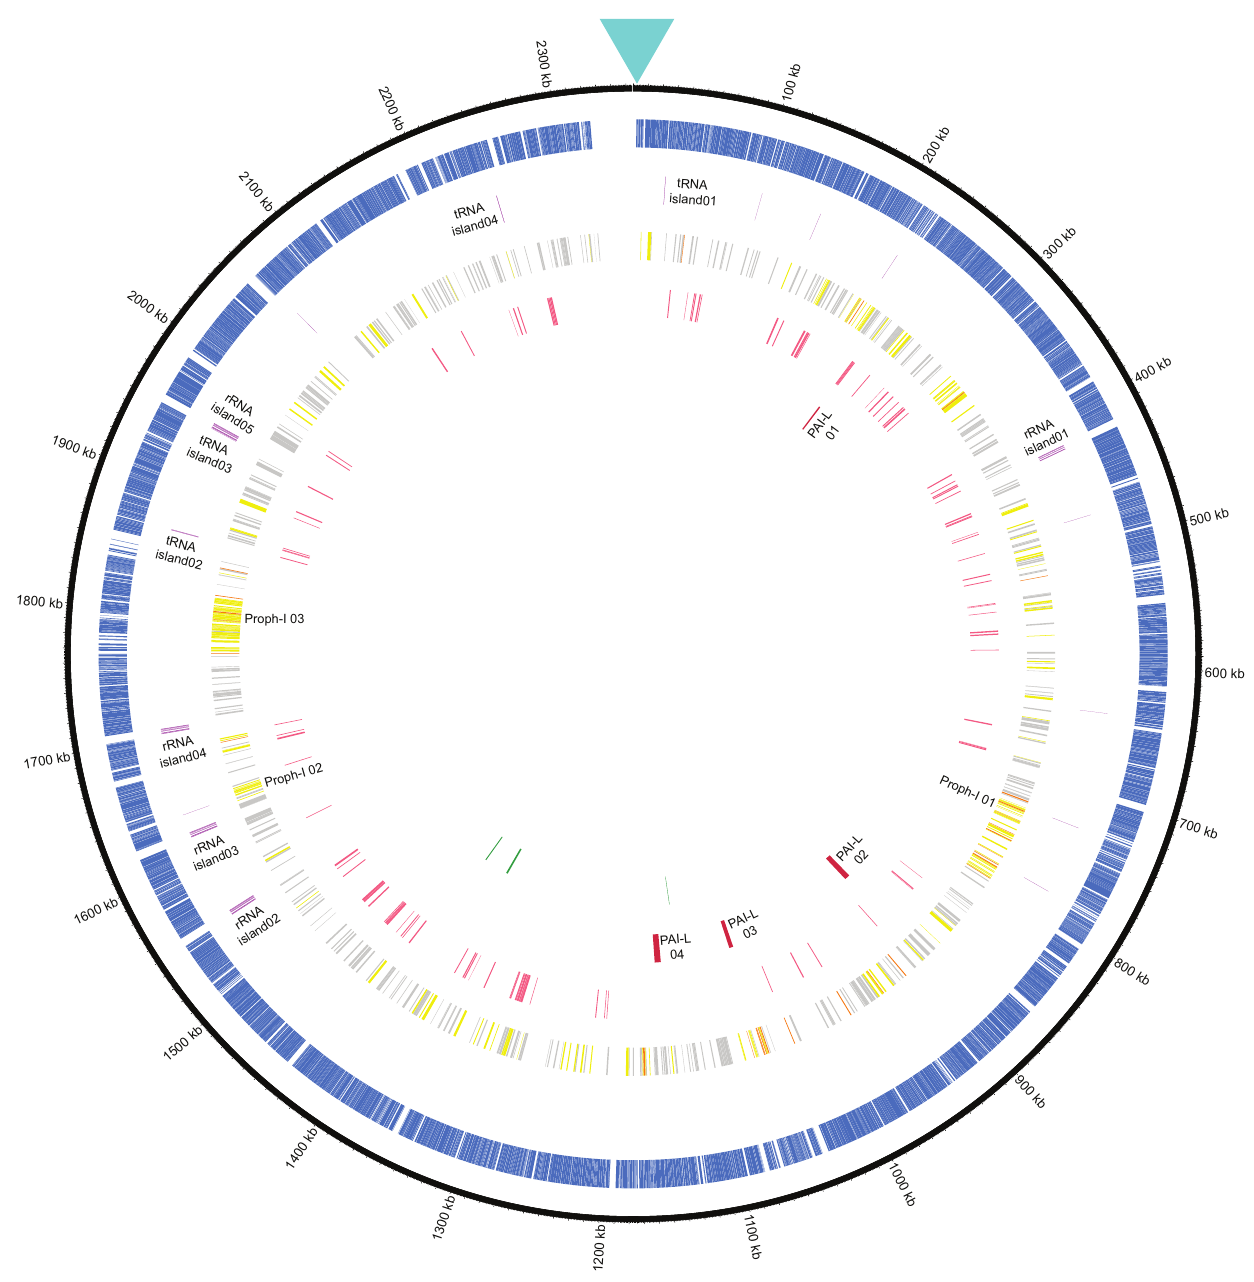
Figure 1. Circular representation of H.parasuis strain ZJ0906 genome. From the outer to inner layers, the circle shows (i) nucleotide positions in kilobases (kb) (black); (ii) CDSs annotated by NCBI non-redundant (nr) database (blue); (iii) RNA regions whereas rRNA islands and tRNA islands were labeled accordingly (purple); (iv) ACLAME database-annotated horizontal transferring genes, classified by their putative origins – plasmids (grey), prophages (yellow) and phages (orange) whereas the 3 major prophage islands were labeled accordingly; (v) VFDB-annotated potential virulence genes (light red); (vi) PAIDB-annotated PAI-like regions labeled accordingly (dark red); ARDB-annotated potential drug-resistance genes (dark green). doi:10.1371/journal.pone.0068350.g001 pleuropneumoniae serovar 3 JL03 which have 142 orthologs, even